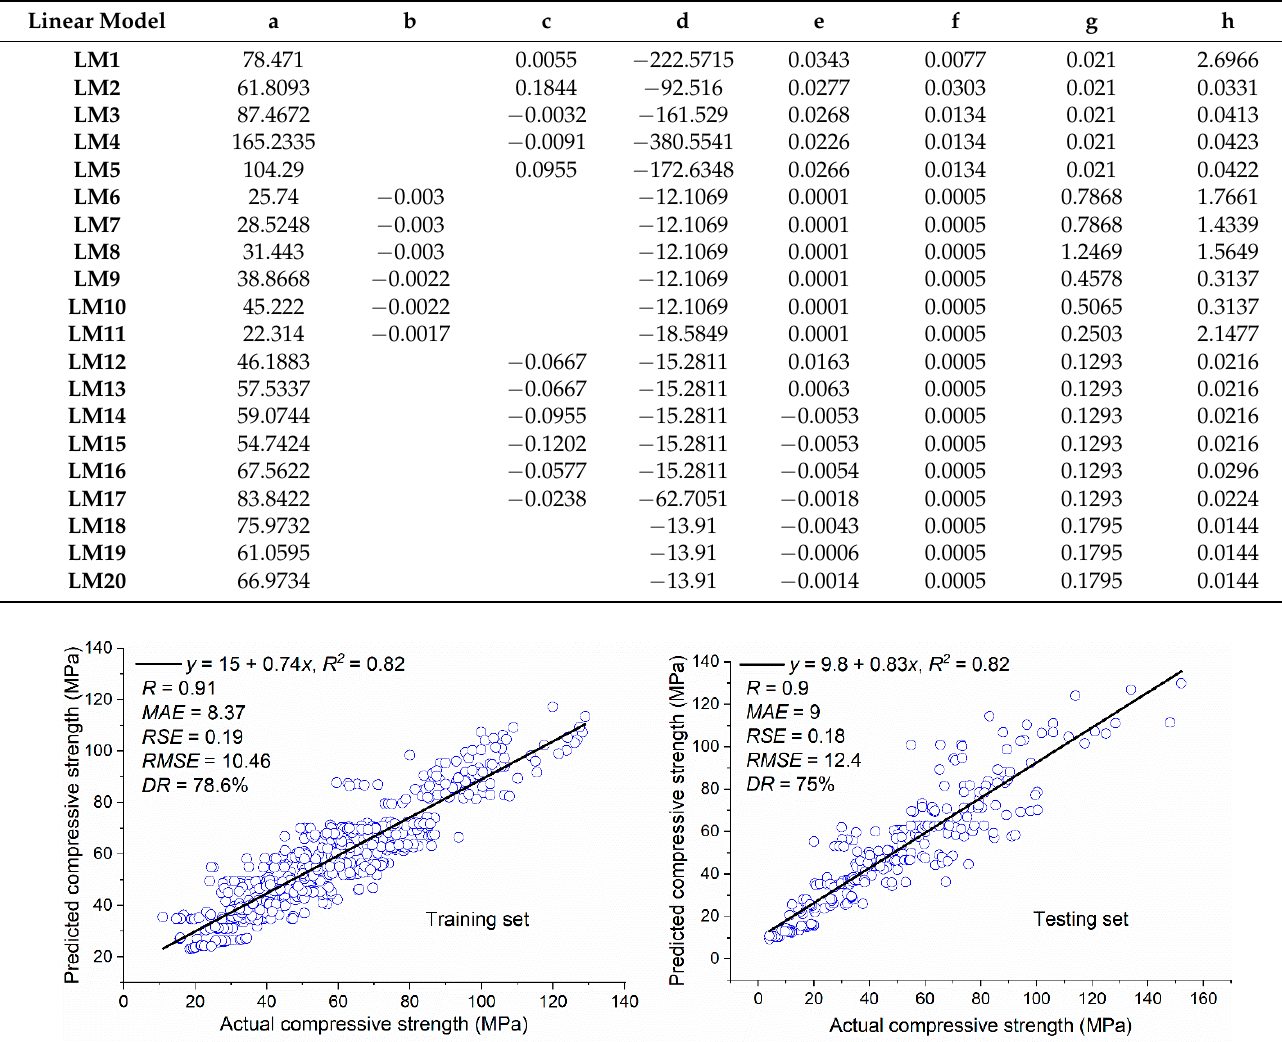
Figure 6. Comparison of the linear regression analysis, GEP, and M5P for the prediction of the CS of concrete made with SF: ( a ) training dataset; ( b ) testing dataset.